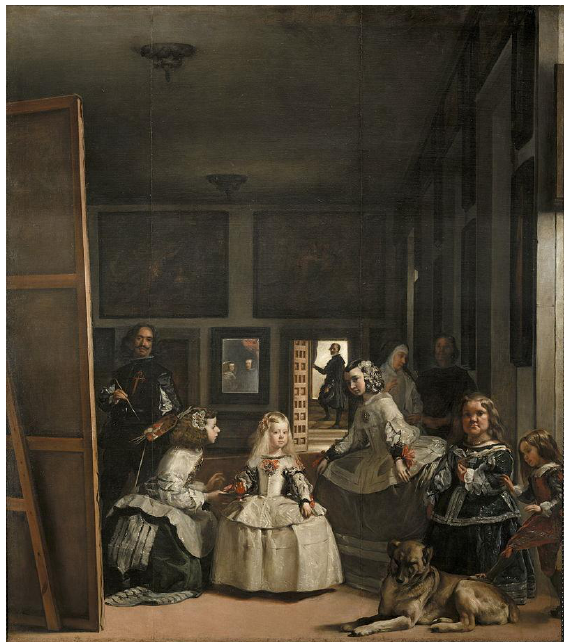
Figure 5. Diego Velázquez. Las meninas (1656), Galería online, Museo del Prado, Madrid, Spain. Public Figure 5. Diego Vel á zquez. Las meninas (1656), Galer í a online, Museo del Prado, Madrid, Spain. Public domain. (Velázquez 1656). domain. (Vel á zquez